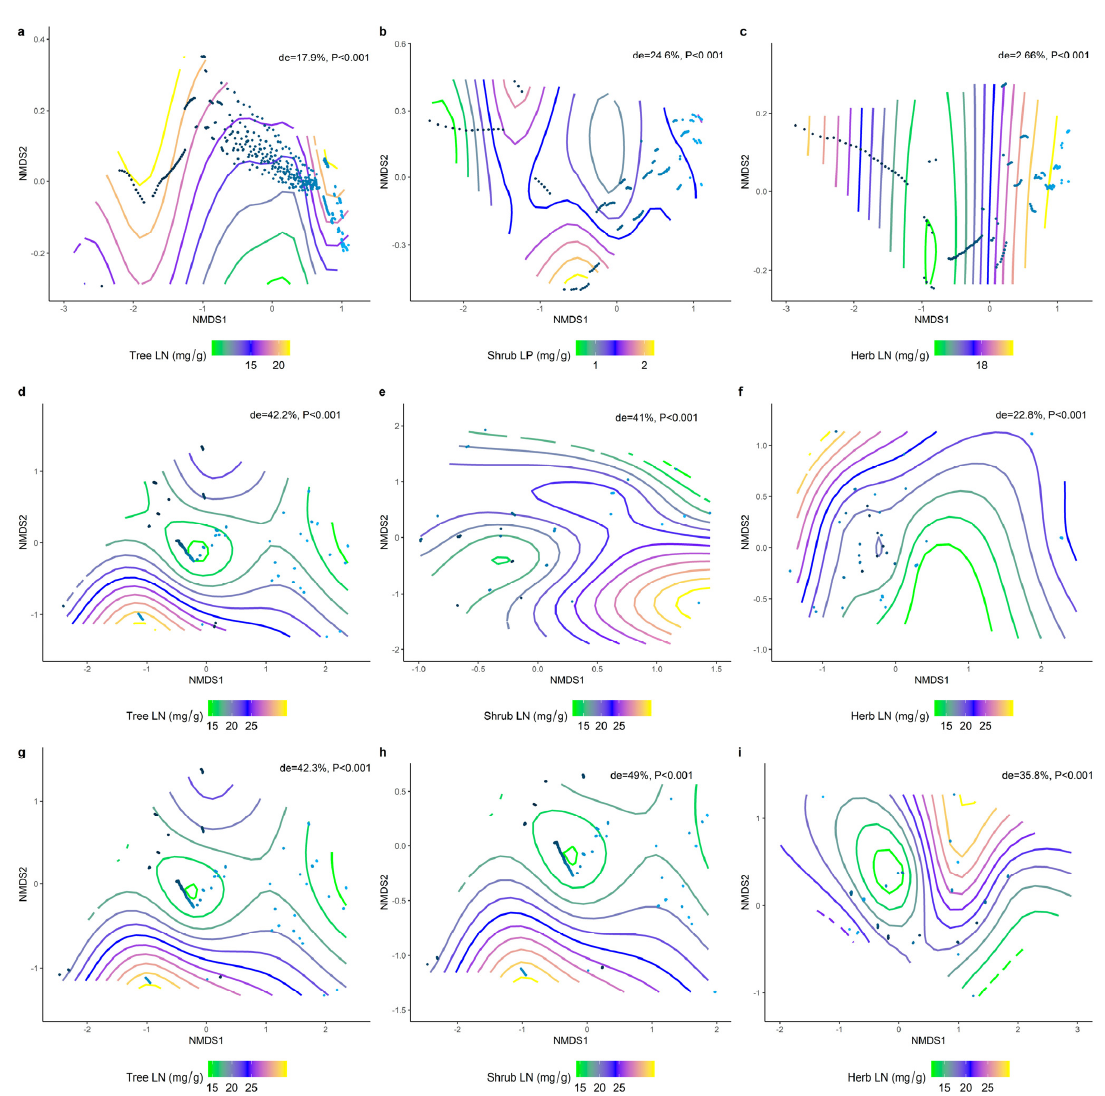
Figure 9. The NMDS ranking of climatic and soil factors with different life forms of LN. Value of de represents the deviation explained by the corresponding model. ( a ) NMDS ranking of soil factors with tree levels LN; ( b ) NMDS ranking of soil factors with shrub levels LN; ( c ) NMDS ranking of soil factors with herb levels LN; ( d ) NMDS ranking of climatic factors with tree levels LN; ( e ) NMDS ranking of climatic factors with shrub levels LN; ( f ) NMDS ranking of climate factors and herb levels LN; ( g ) NMDS ranking of the sum of soil factors and climate factors and tree levels LN; ( h ) NMDS ranking of the sum of soil factors and climate factors and shrub levels LN; ( i ) NMDS ranking of the sum of soil factors and climate factors and herb levels LN. Trait stacking indicates that abiotic factors, indicated by points on the NMD, are associated with higher or lower trait values, consistent with a colored trait gradient. Note that if the relationship between the LN and abiotic factors is linear, the gradient splines will be parallel. Nonlinear relationships between LN and abiotic factors are repre- sented by curve splines.